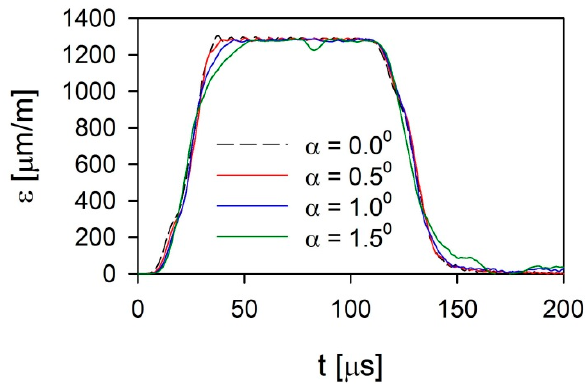
Figure 6. Incident-disturbed pulses for SHPB using a pulse shaper for an imperfection in the form of an inclination angle α between the striker and input bar.